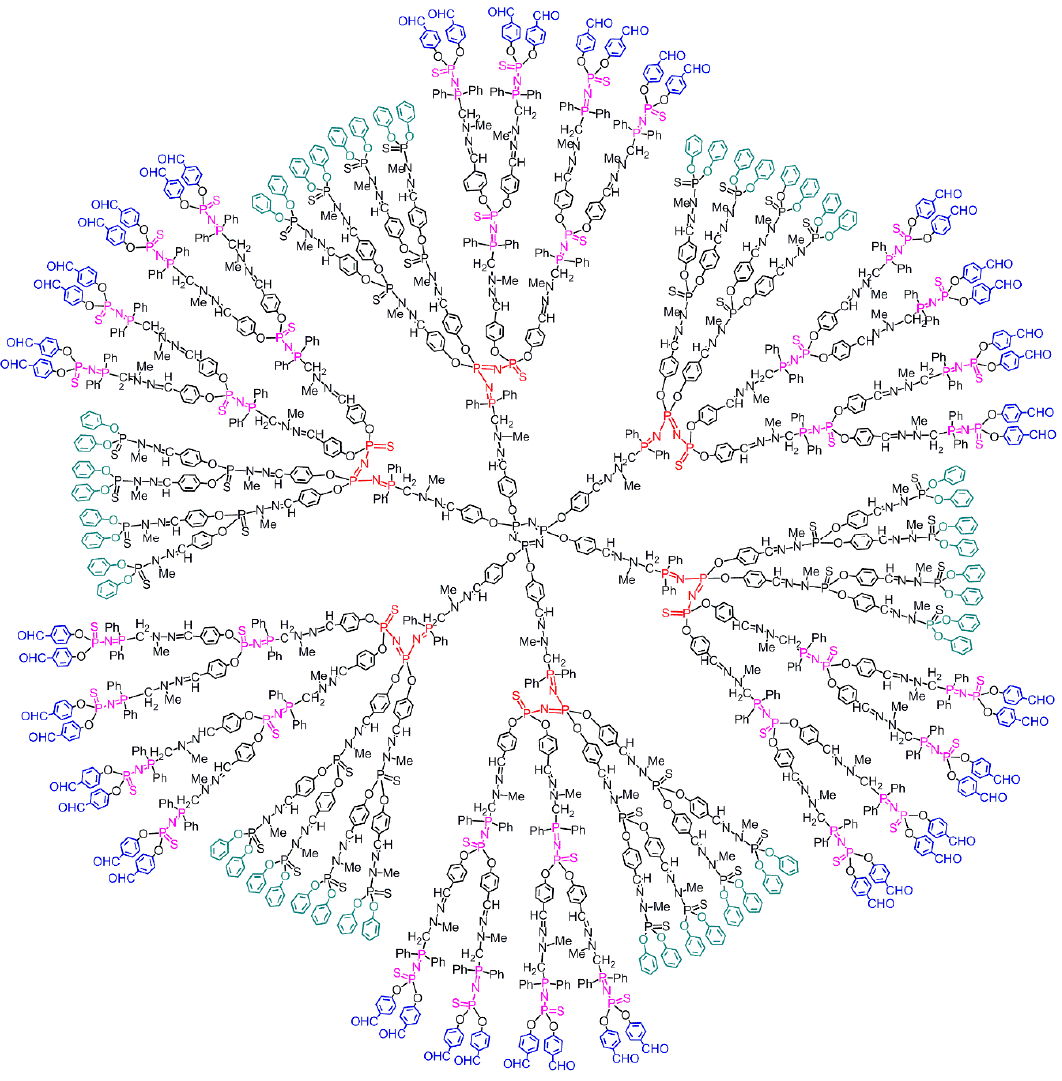
Figure 14. Dendritic structure with two types of functions disposed as patches on the surface of the dendrimer.